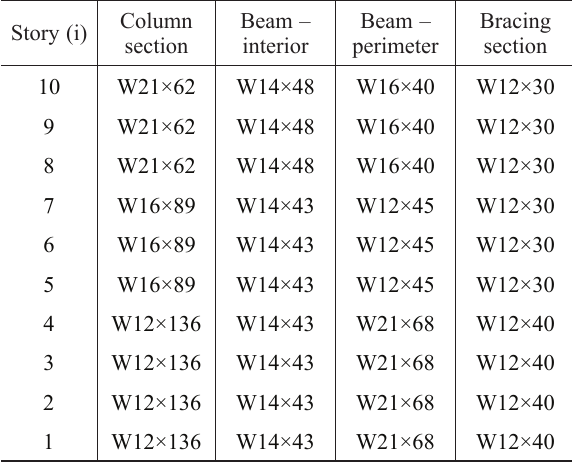
Table 3. Member data horizontally irregular – Eccentrically Braced Frame (EBF) (Young, Adeli 2014a,